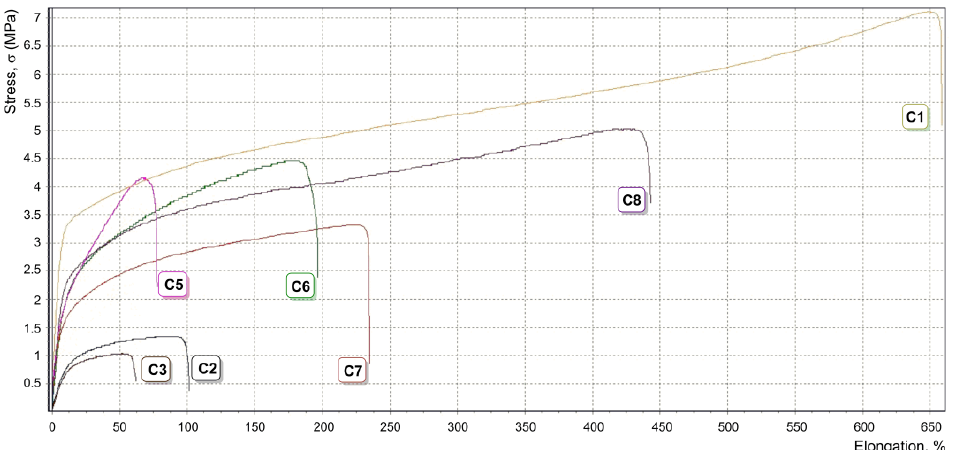
Figure 7. Stress-strain curves of the ES fibers C1 – C3 , C5 – C8 (Table 1).